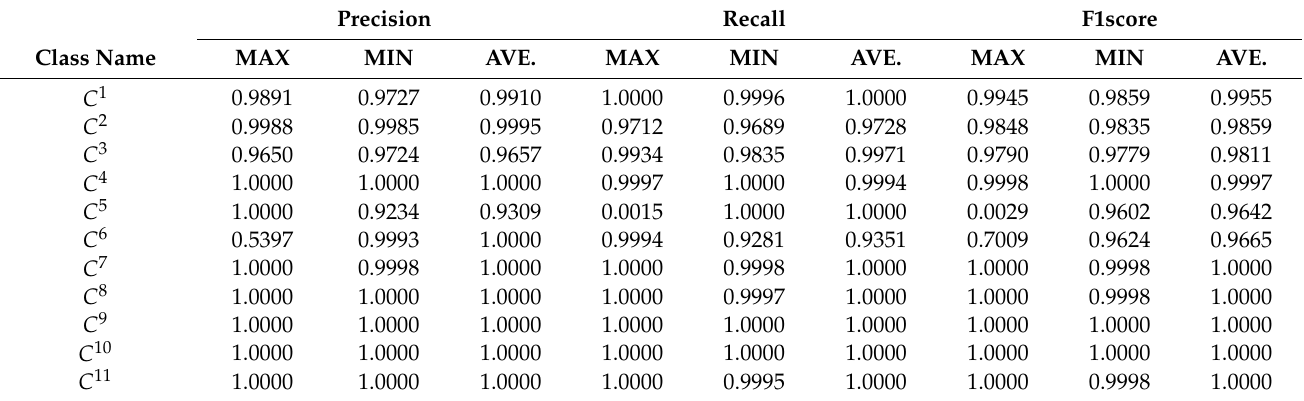
Table 11. Performance analysis for N-BaIoT with XGB and MI feature selection on the test